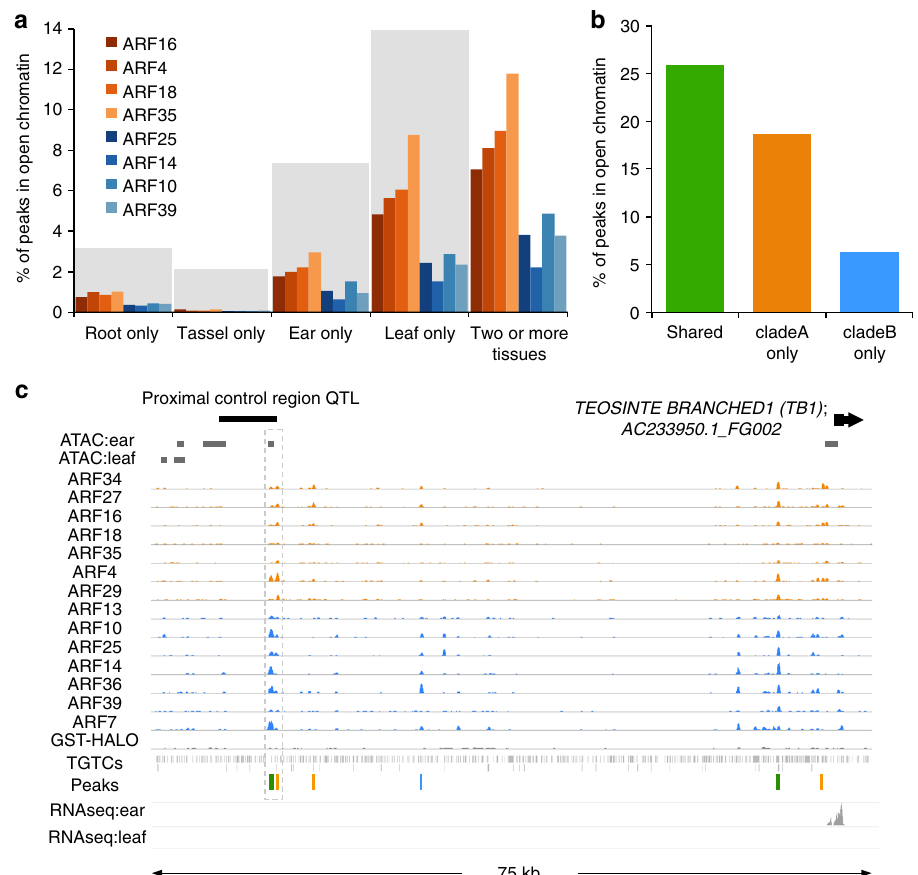
Fig. 5 ARF peaks overlap with regions of open chromatin. a Overlap of DAP-seq peaks with open chromatin regions from different tissues. Gray bars represent coverage of open chromatin datasets relative to leaf dataset (ATAC-seq plus MNase datasets which contained the greatest coverage). Clade A ARFs (orange), clade B ARFs (blue) b . Percentage of peaks for the shared, clade A-only, and clade B-only peak types that overlapped with a region of open chromatin found in at least one of four different tissue types. c Genome browser screenshot showing overlap of ear-speci fi c region of open chromatin and ARF peaks (gray dashed box) in the proximal control region of the upstream TB1